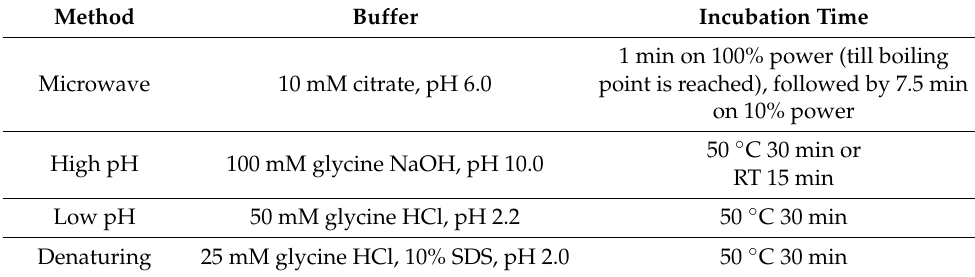
Table 1. List of antibody stripping